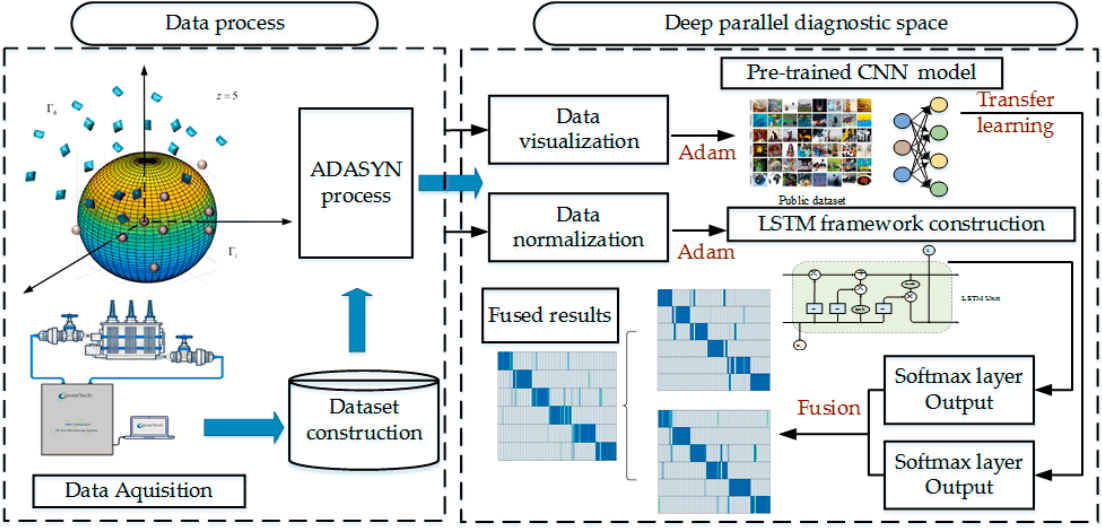
Figure 1. Deep parallel diagnostic framework.